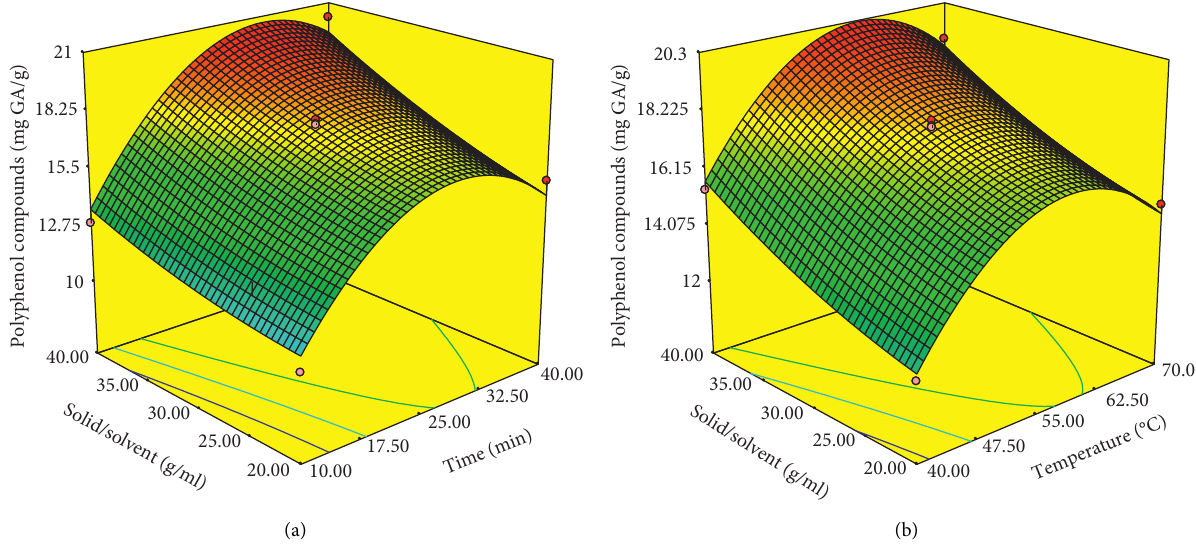
Figure 4: Response surface for the effect of (a) water/solid ratio and sonication time (sonication temperature � 55 ° C) and (b) sonication temperature and water/solid ratio (sonication time � 25 ° C) on the amount of phenolic